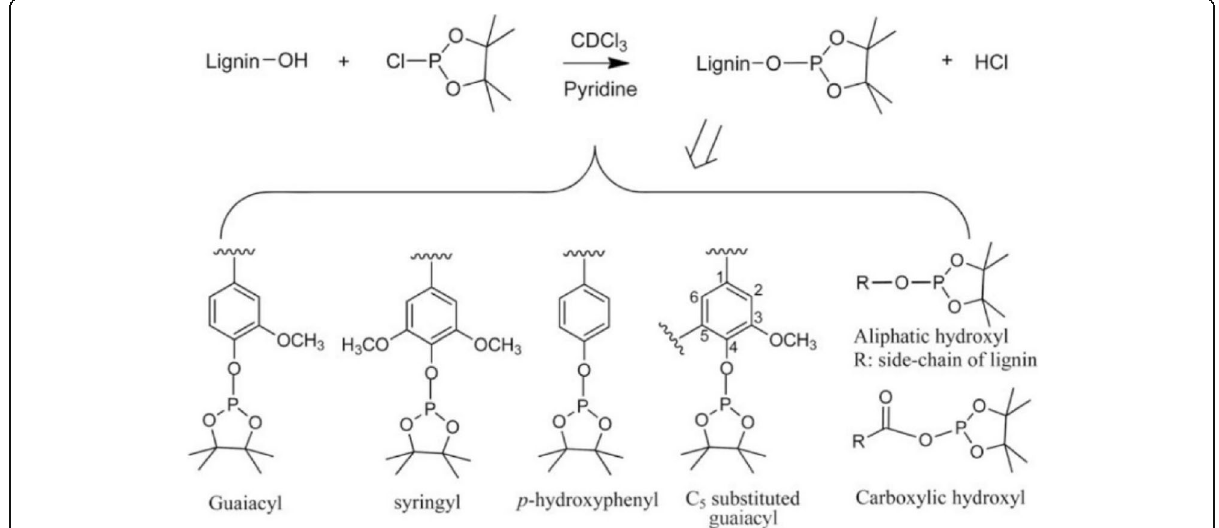
Fig. 3 Phosphitylation of hydroxyl groups in lignin structural units with 2 – chloro – 4,4,5,5 – tetramethyl – 1,3,2 – dioxaphospholane (TMDP). Reprinted with permission from ref. [60]